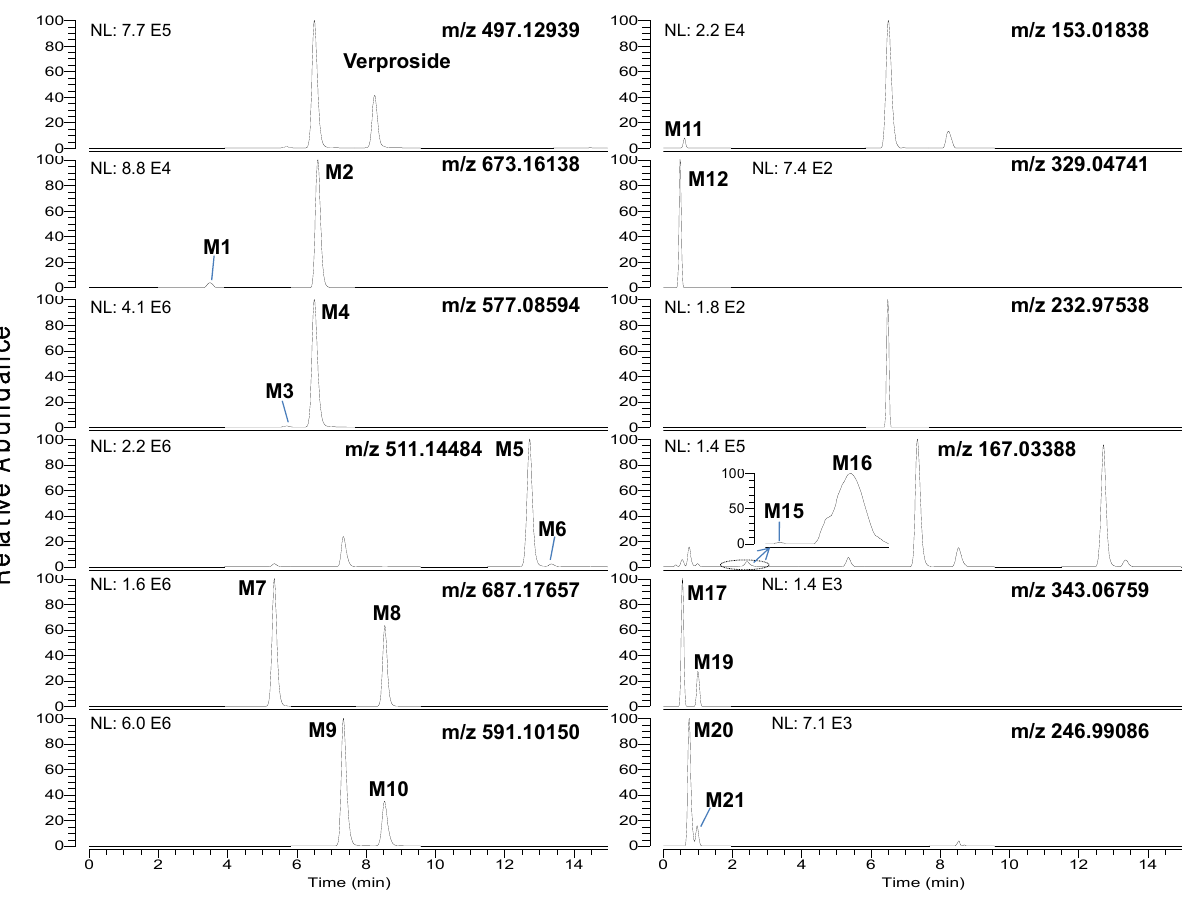
Figure 1. Extracted ion chromatograms of verproside and its possible metabolites in the bile samples obtained for 6 hours after intravenous administration of verproside at a dose of 10 mg/kg to a Sprague Dawley rat using 5 ppm mass